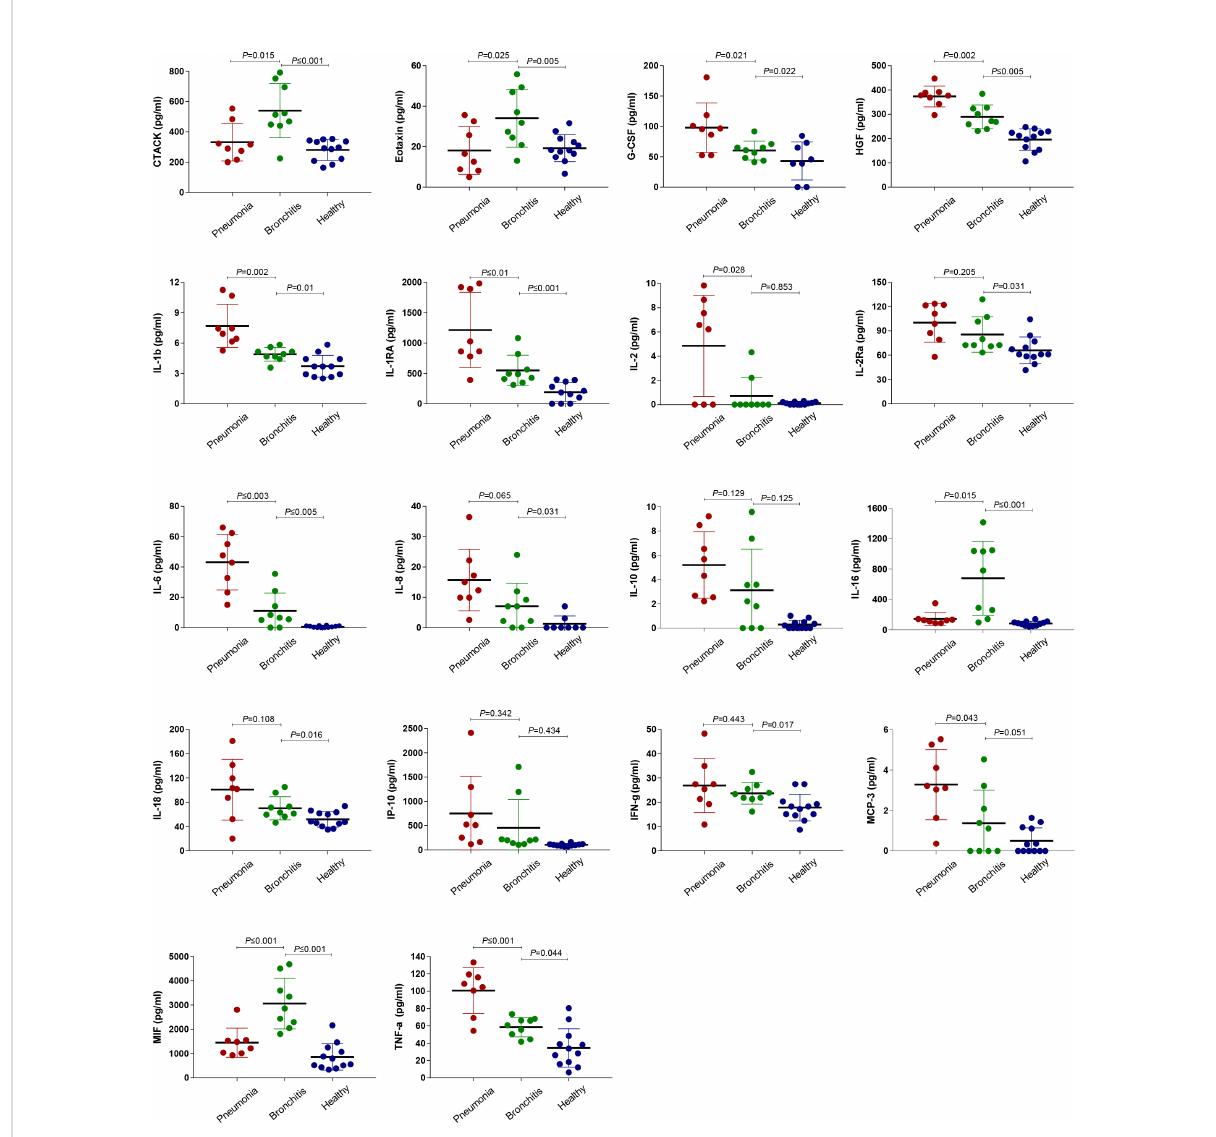
FIGURE 4 Comparison of plasma cytokine/chemokine concentrations between healthy controls as well as the pneumonia and bronchitis cases infected with C. psittaci . Samples were collected at the earliest time point for assays measuring the concentrations of 48 cytokines and chemokines. Values are presented in pg/ml. The mean ± standard error is shown for each group and the p -values are determined by t -test. A p -value between 0.01 and 0.05, between 0.001 and 0.01, and between 0.0001 and 0.001 was considered statistically signi fi cant, very signi fi cant, and extremely signi fi cant,